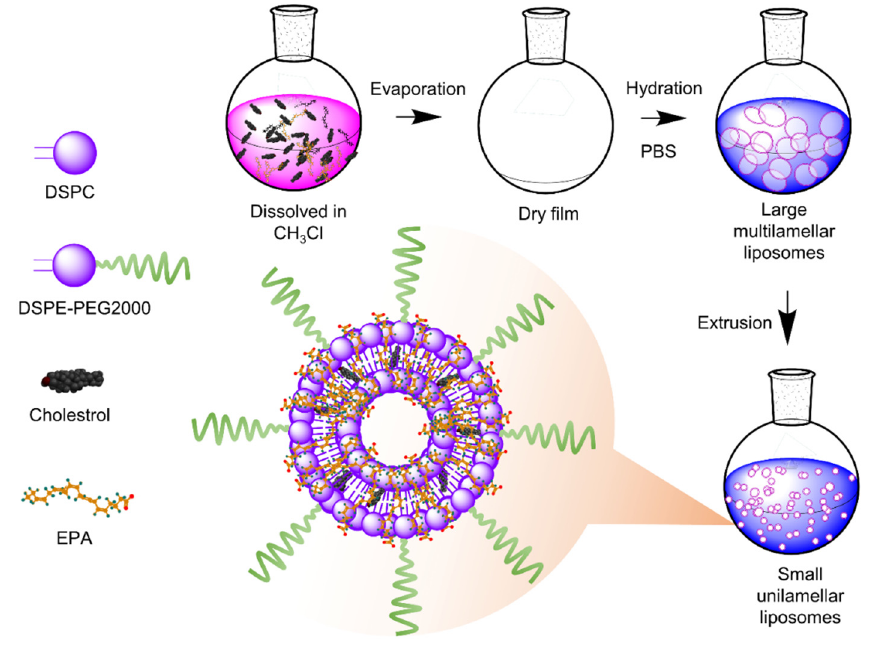
Figure 1. Liposomes were prepared by lipid film hydration method and EPA was efficiently loaded in a lipid bilayer of liposomes.